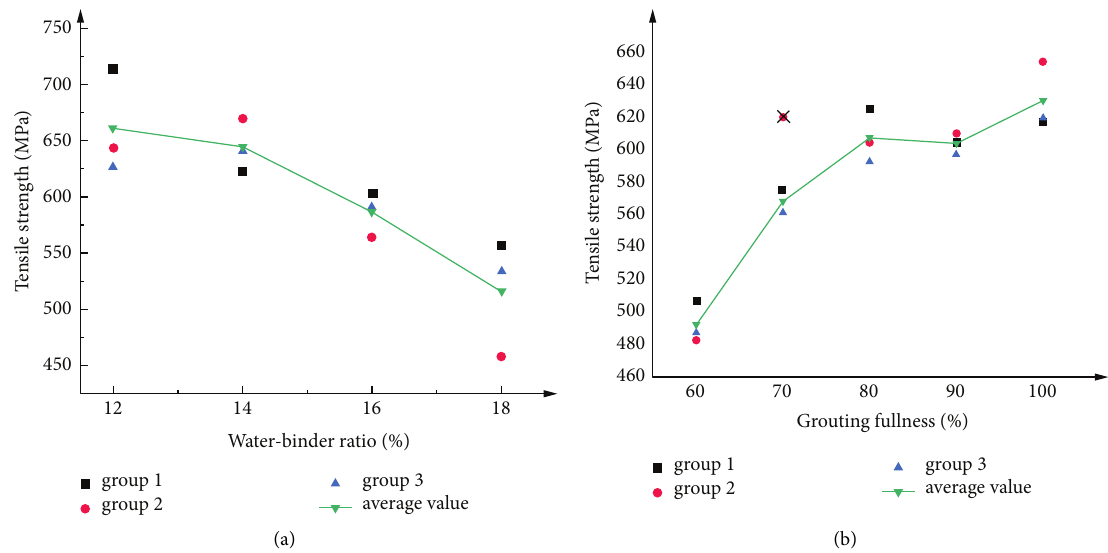
Figure 8: Comparison of tensile strength with different condition. (a) Different grout’s strength. (b) Different grouting fullness.